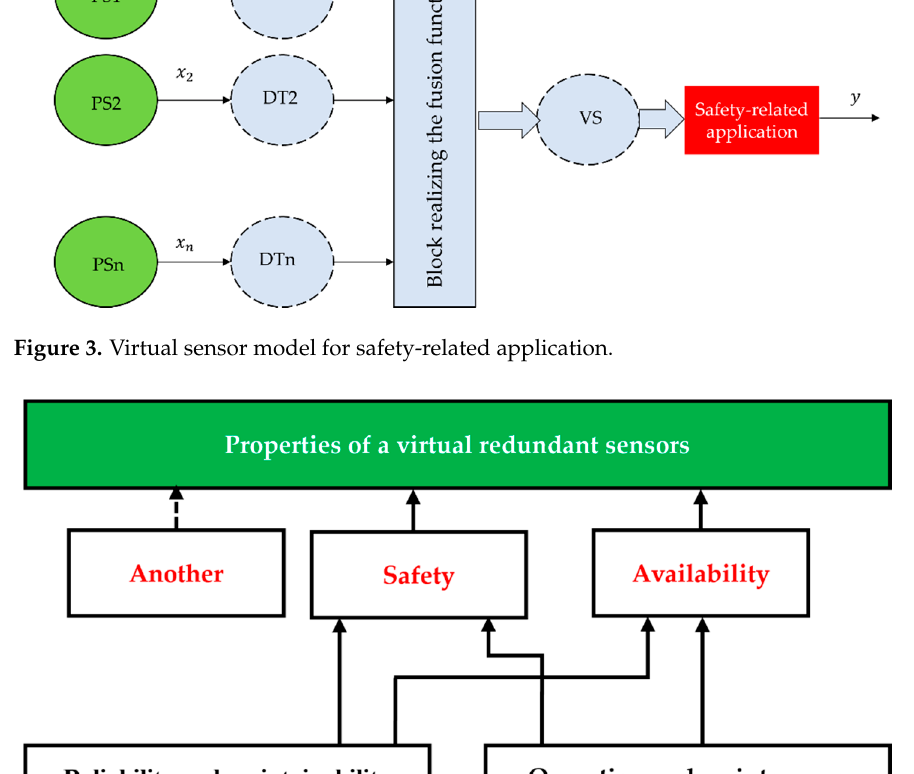
Figure 3. Virtual sensor model for safety-related application.